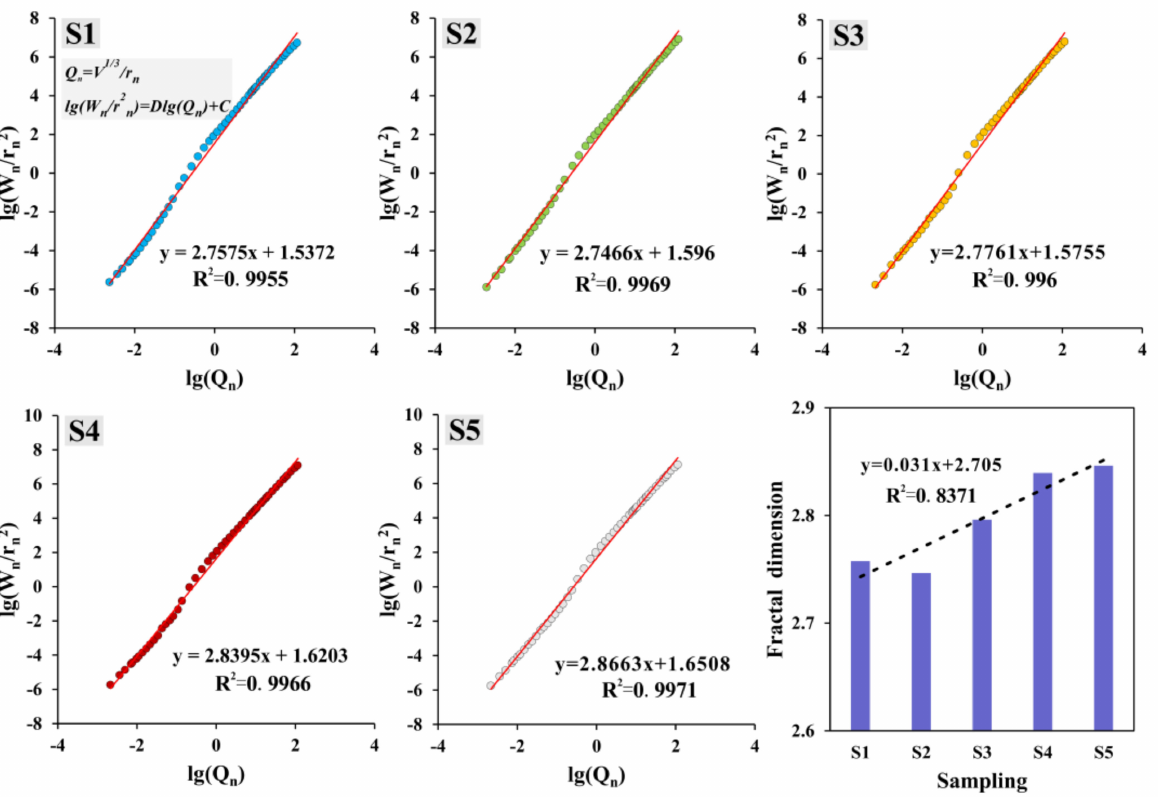
Figure 12. S1–S5 fractal dimension calculation